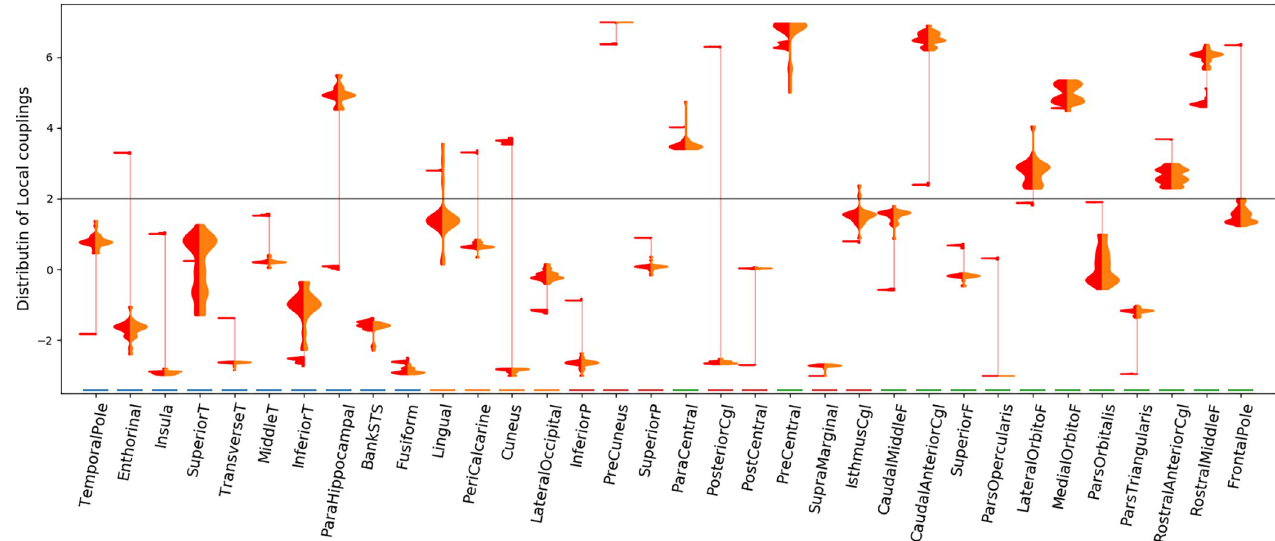
Fig 6. Density estimates of local couplings by brain regions for the best solutions in terms of sFC and trFC similarity. Each column on the x-axis is a brain region. In each column, there are vertically two density estimates of local couplings with the value indicated by the y-axis. The densities on the left (red) contain the number of solutions that best predict sFC and trFC for a given local coupling (y-axis). The vertical thin red line connects clusters of solutions in the same brain region. The densities on the right (orange) are a subset of the local couplings of the densities on the left. This subset contains solutions from only one cluster of local couplings. The horizontal gray line indicates the critical local